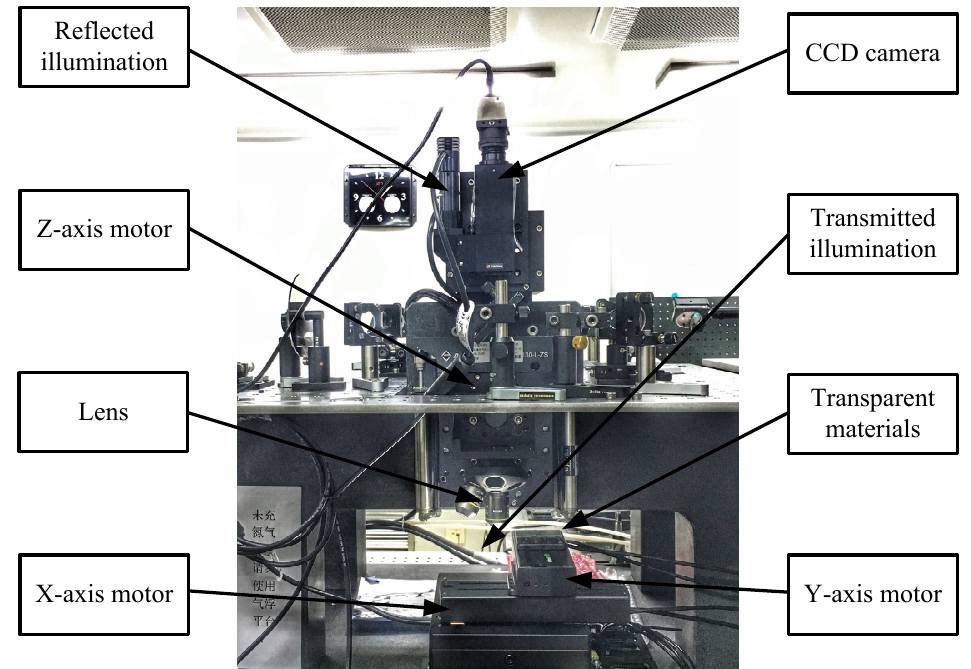
Figure 5. Microscope experimental